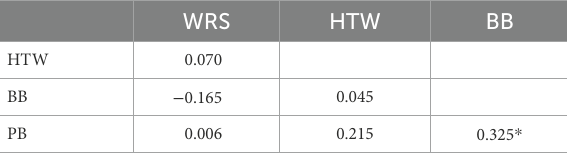
TABLE 9 Results from Spearman’s Rho bivariate correlation analysis for motor competence for females ( n = 42). WRS HTW